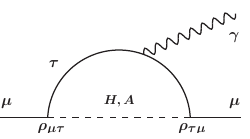
Figure 8. One-loop mechanism for muon g